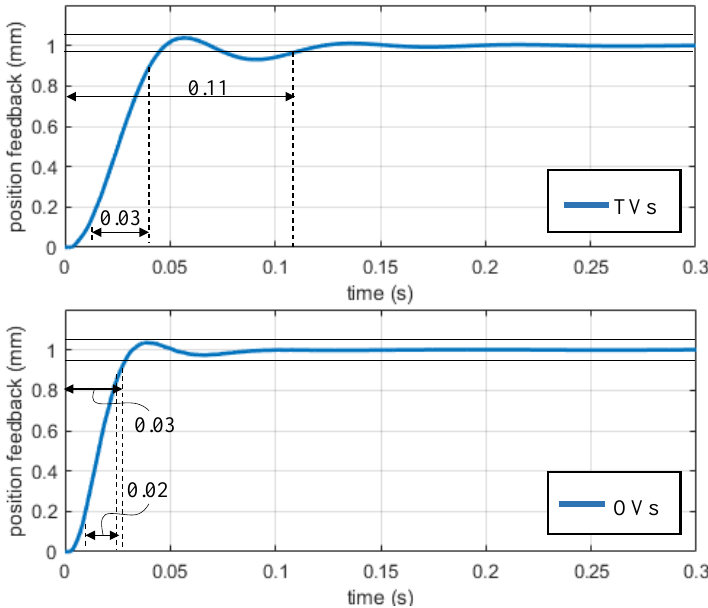
using TVs and OVs. using TVs and OVs. Figure 9. The step responses of optical scale feedback X s using TVs and 𝑋𝑋 𝑠𝑠 𝑋𝑋 𝑠𝑠